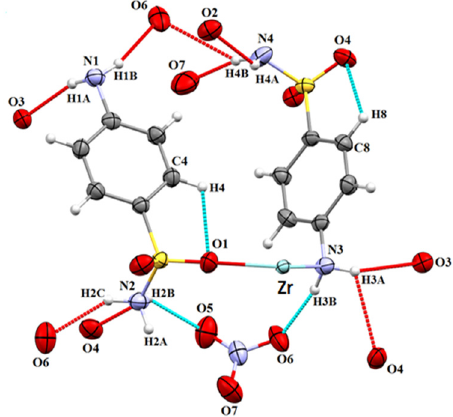
Figure 11: Representation of inter and intramolecular interactions of hydrogen type in the asymmetric unit of complex ( 1 ) . The blue dots represent the intramolecular interactions N – H...O, C – H...O, The red dots represent the intermolecular N – H...O